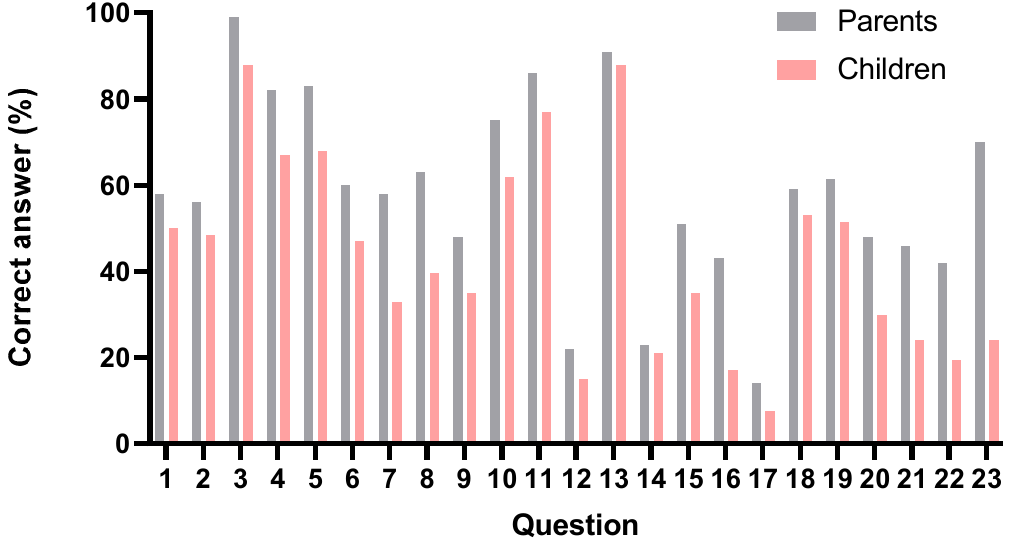
Figure 1. Comparison of parents’ and children’s correct answers according to IBD-KID question, showing areas of higher and lower knowledge.